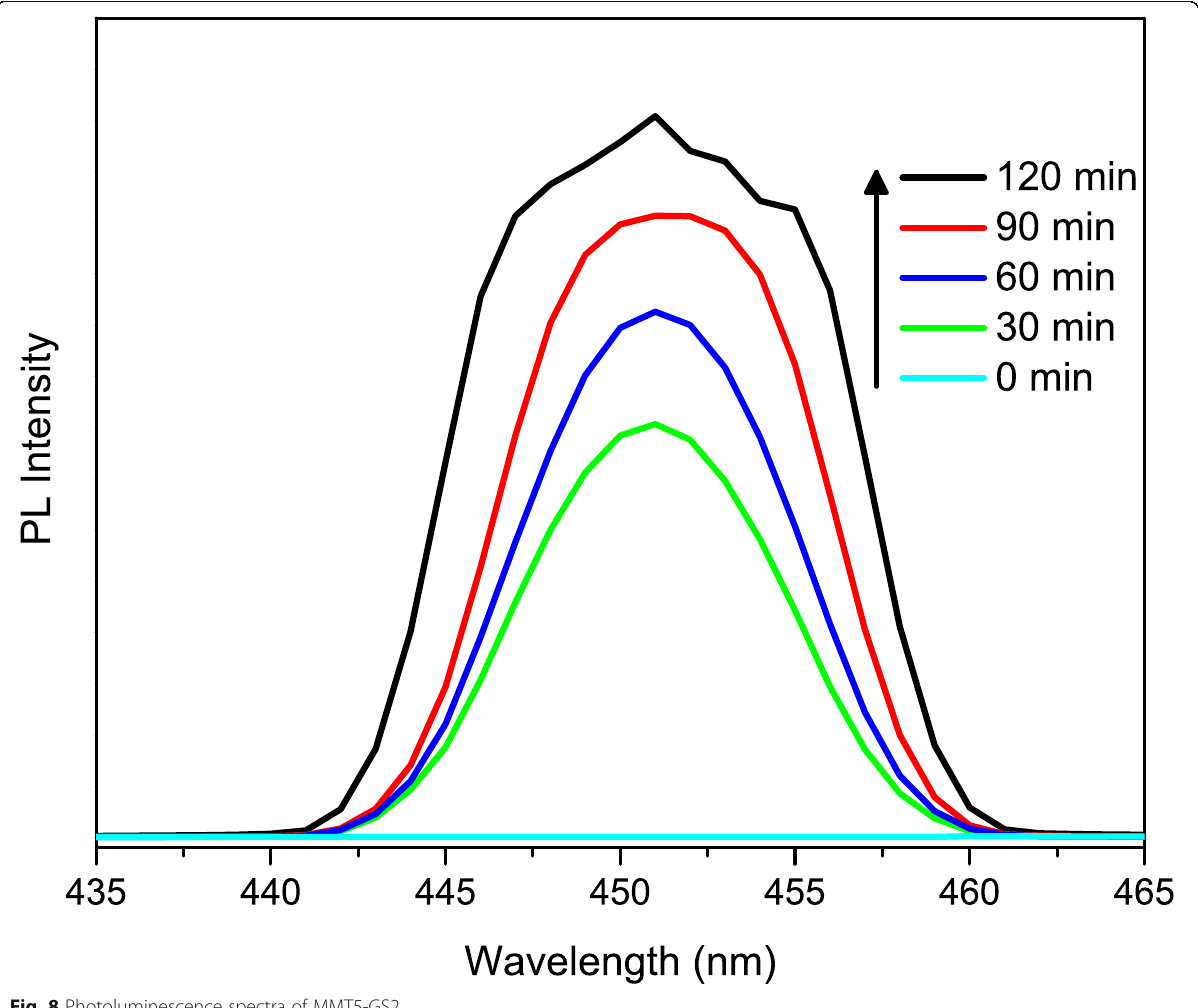
Fig. 8 Photoluminescence spectra of